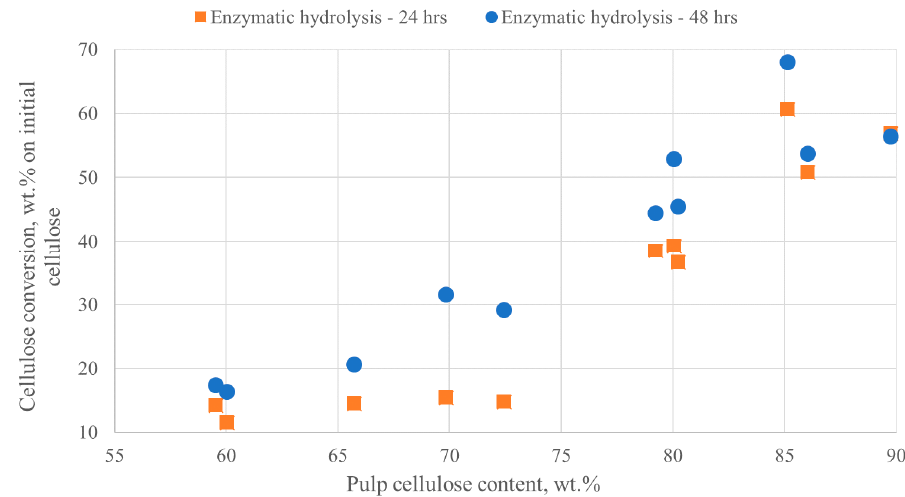
Figure 5. Cellulose conversion to glucose via enzymatic hydrolysis at 24 and 48 h vs pulp cellulose content.